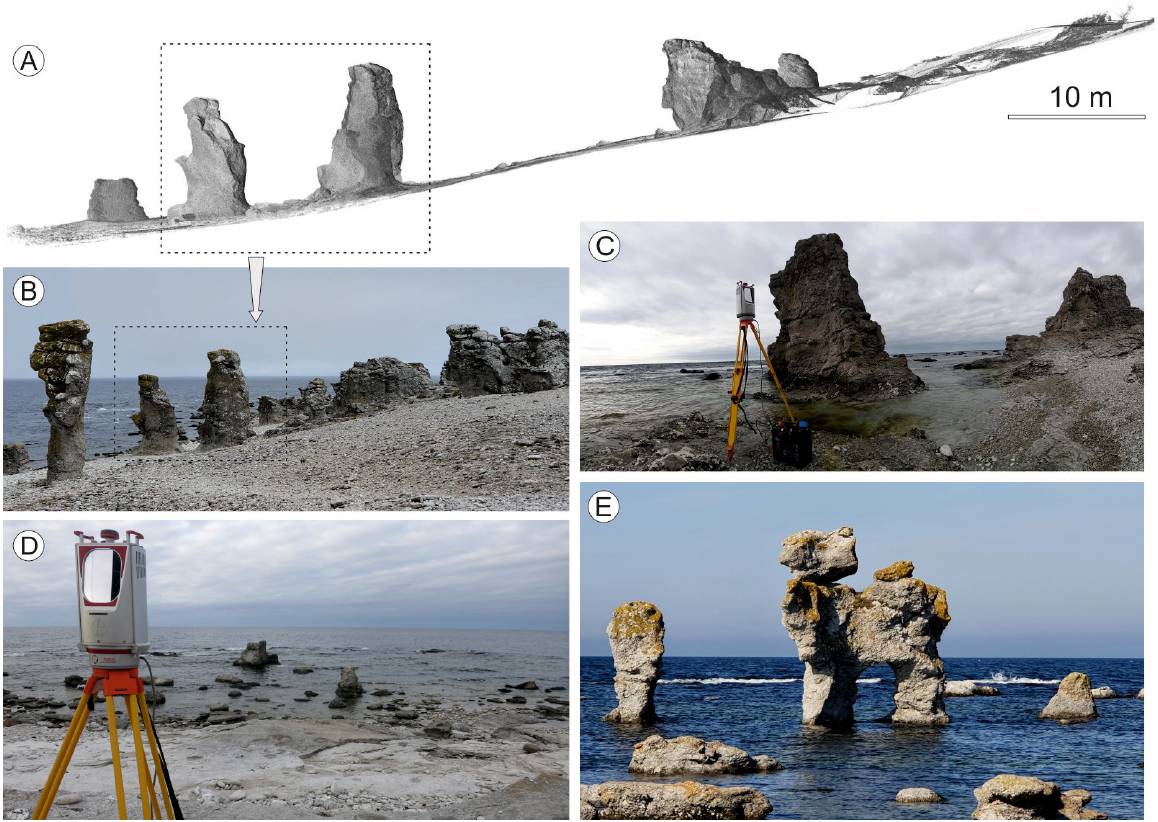
Figure 2. Rocky rauk coast on Fårö Island: ( A ) cross ‐ section of the TLS cloud point for Langham ‐ mars; ( B ) rauk field at Langhammars; ( C ) rauks at Digerhuvud; ( D ) limestone shore platform at Langhammars; ( E ) famous “Hund” rauk at Gamla Hamn (names of field sites are the same as in Figure 1C).